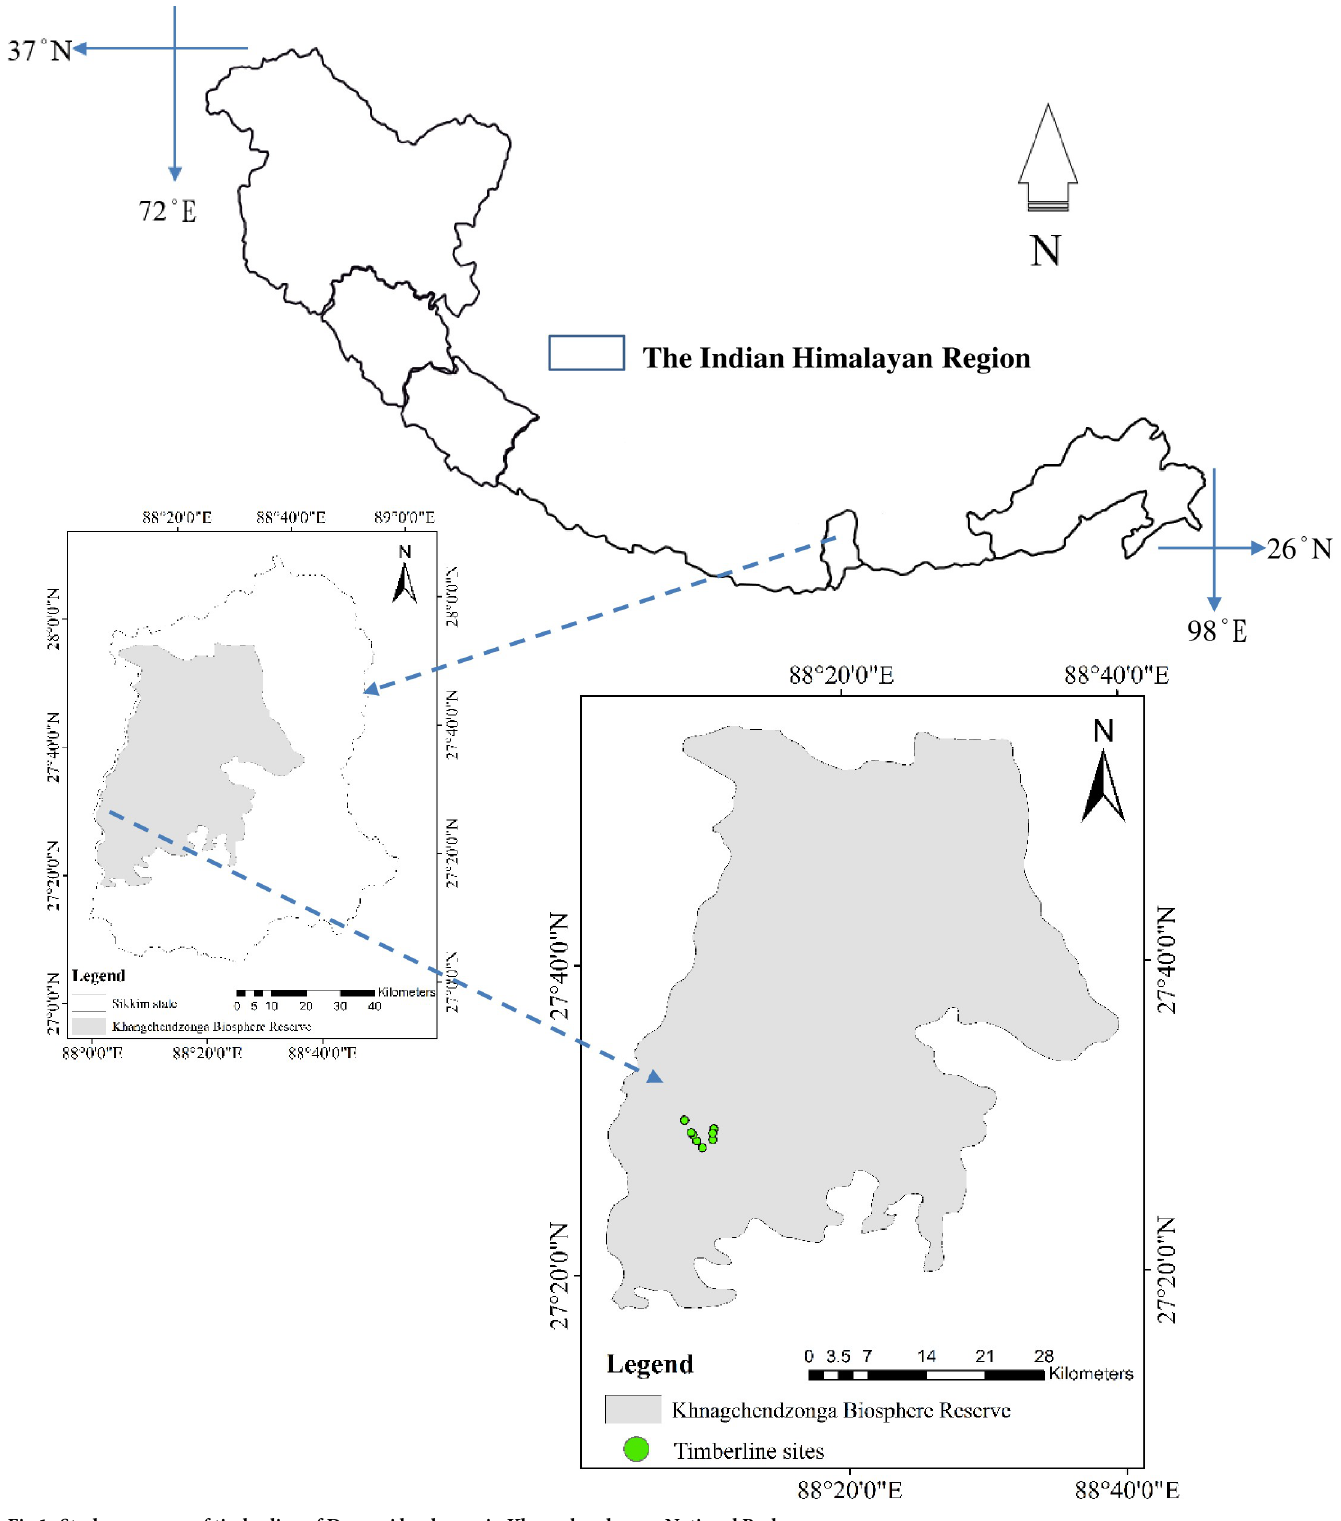
Fig 1. Study area map of timberline of Dzongri landscape in Khangchendzonga National Park.